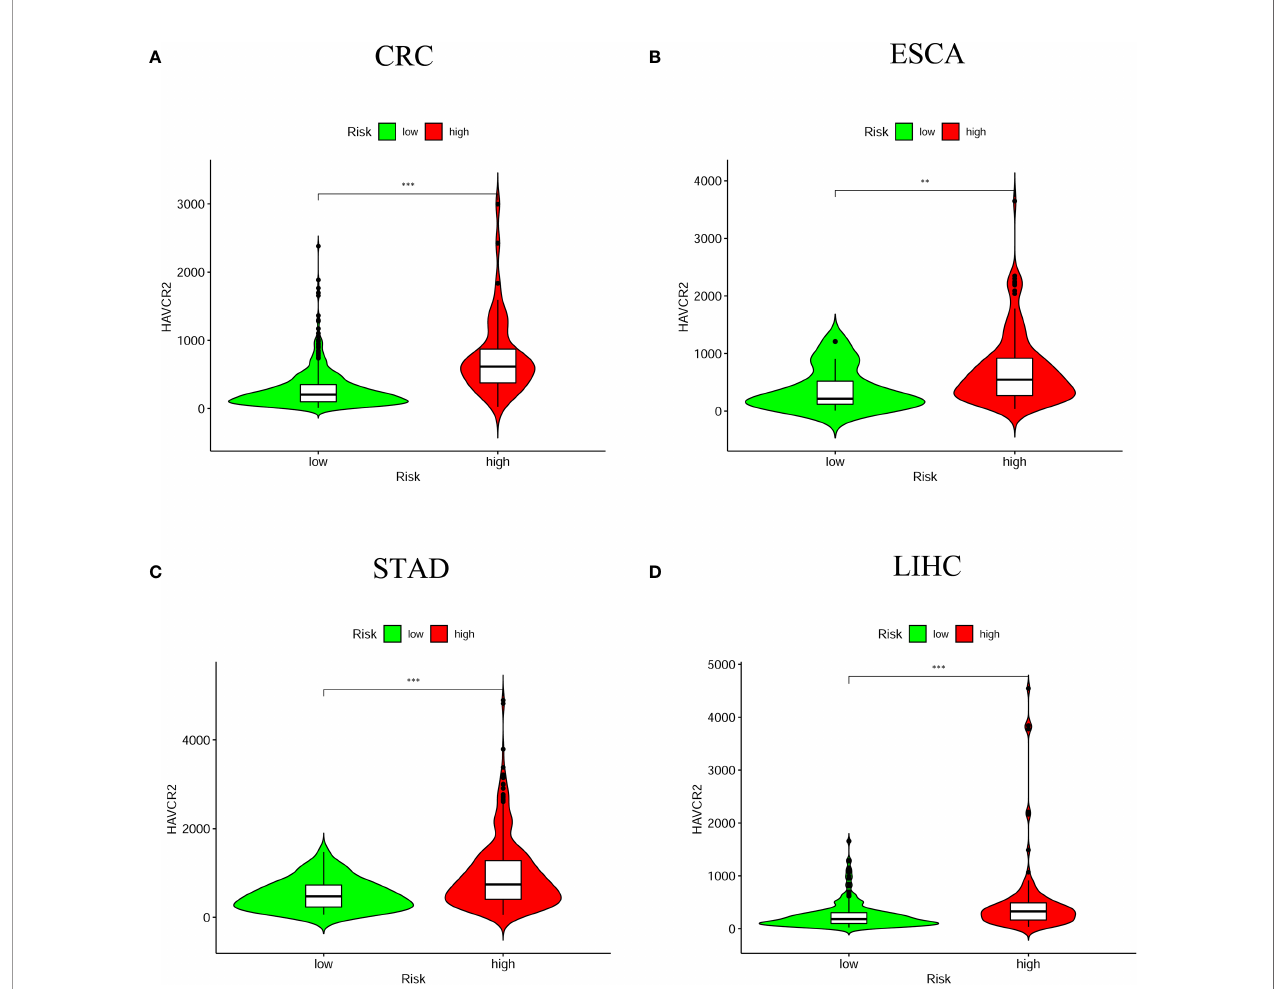
FIGURE 8 | The relationship between risk scores and immune checkpoint inhibitors. HAVCR2 was positively correlated with high-risk groups in the four digestive system tumors (A) CRC; (B) ESCA; (C) STAD; (D) LIHC (**P < 0.01; ***P <